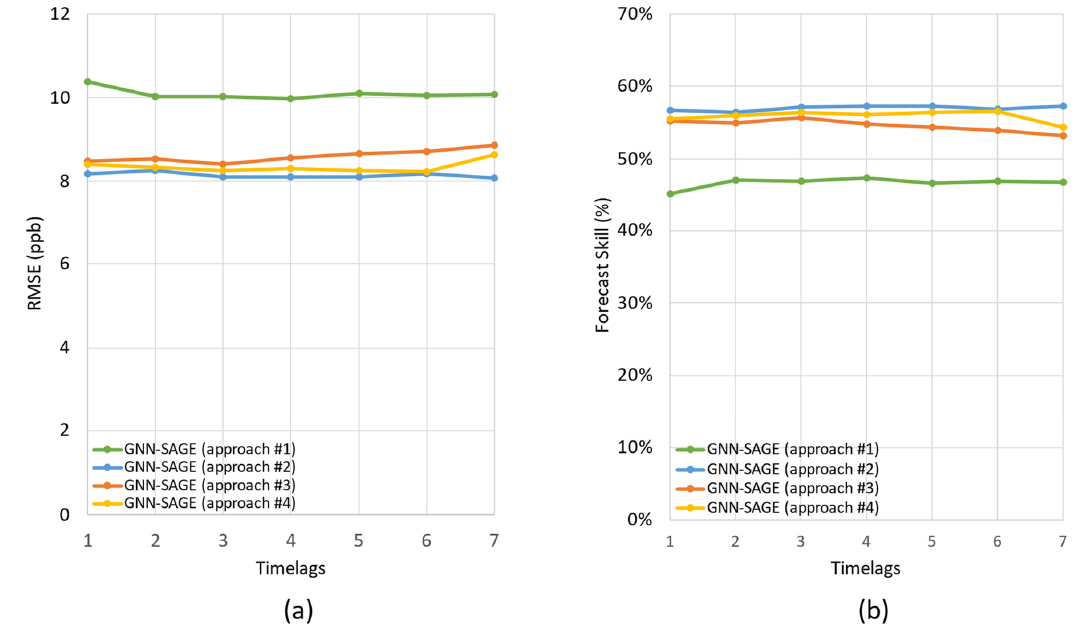
Figure 12. Effect of the different number of time ‐ lags on the model’s prediction for 6 h forecast horizon in terms of RMSE ( a ) and Forecast Skill ( b ).